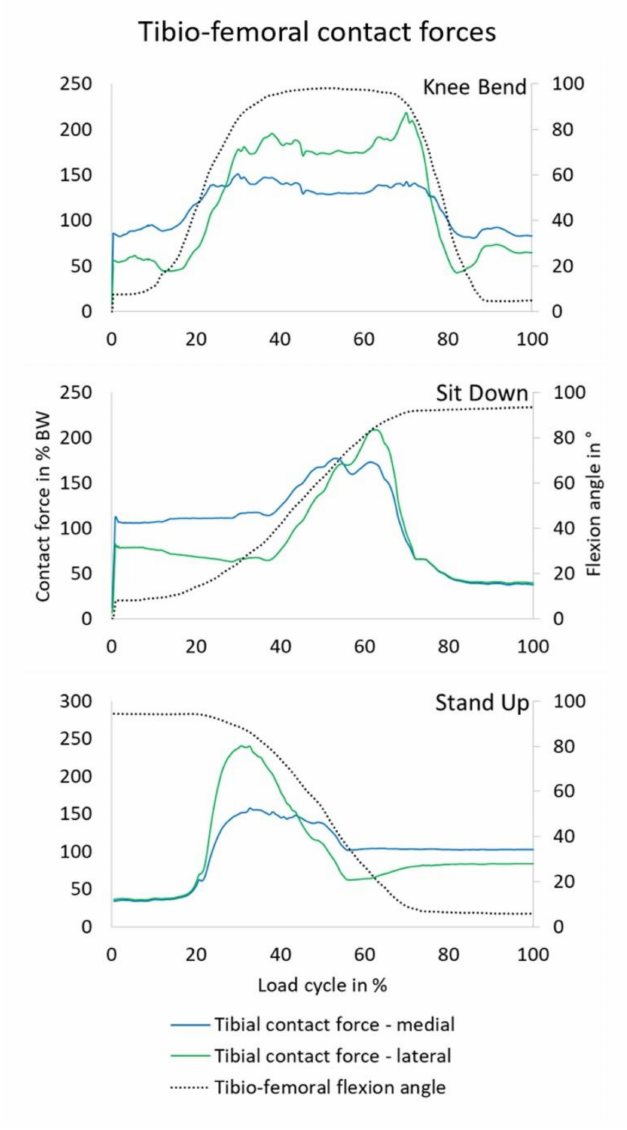
Figure 6. Tibial contact forces in medial and lateral compartment during weight-bearing squat. For the knee bend cycle, the peak patellofemoral force was reached during the upwards movement at 91.4 ◦ of flexion with a magnitude of 2563 N, which is equal to 2.61 BW. The sit down cycle (stand up cycle) led to a maximum patellofemoral force of 2600 N/2.65 BW (2872 N/2.93 BW) at 84.2 ◦ (86.1 ◦ ) of flexion. The main translational and rotational degrees of freedom, which are femoral AP translation and tibial rotation around its axis, were analyzed and are shown in Figure 7. The mean relative femoral AP translation was equal to the tibial translation in the opposite direction, which was directly given by the model. For the 98 ◦ squat, the maximum AP translation between femur and tibia was 16 mm at a flexion angle of 98.1 ◦